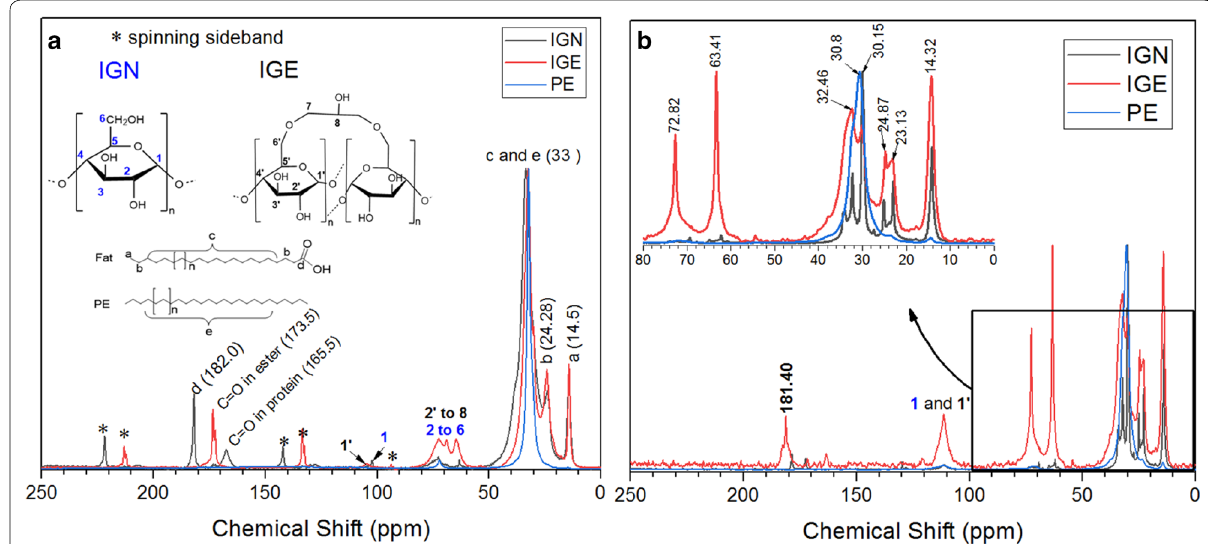
Values represent mean of three replicates with standard deviation in parenthesis